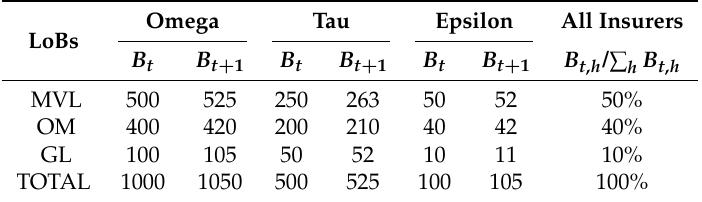
Table 6. Motor oriented Portfolio Mix in terms of Gross premium volumes (amounts in mln of Euro).